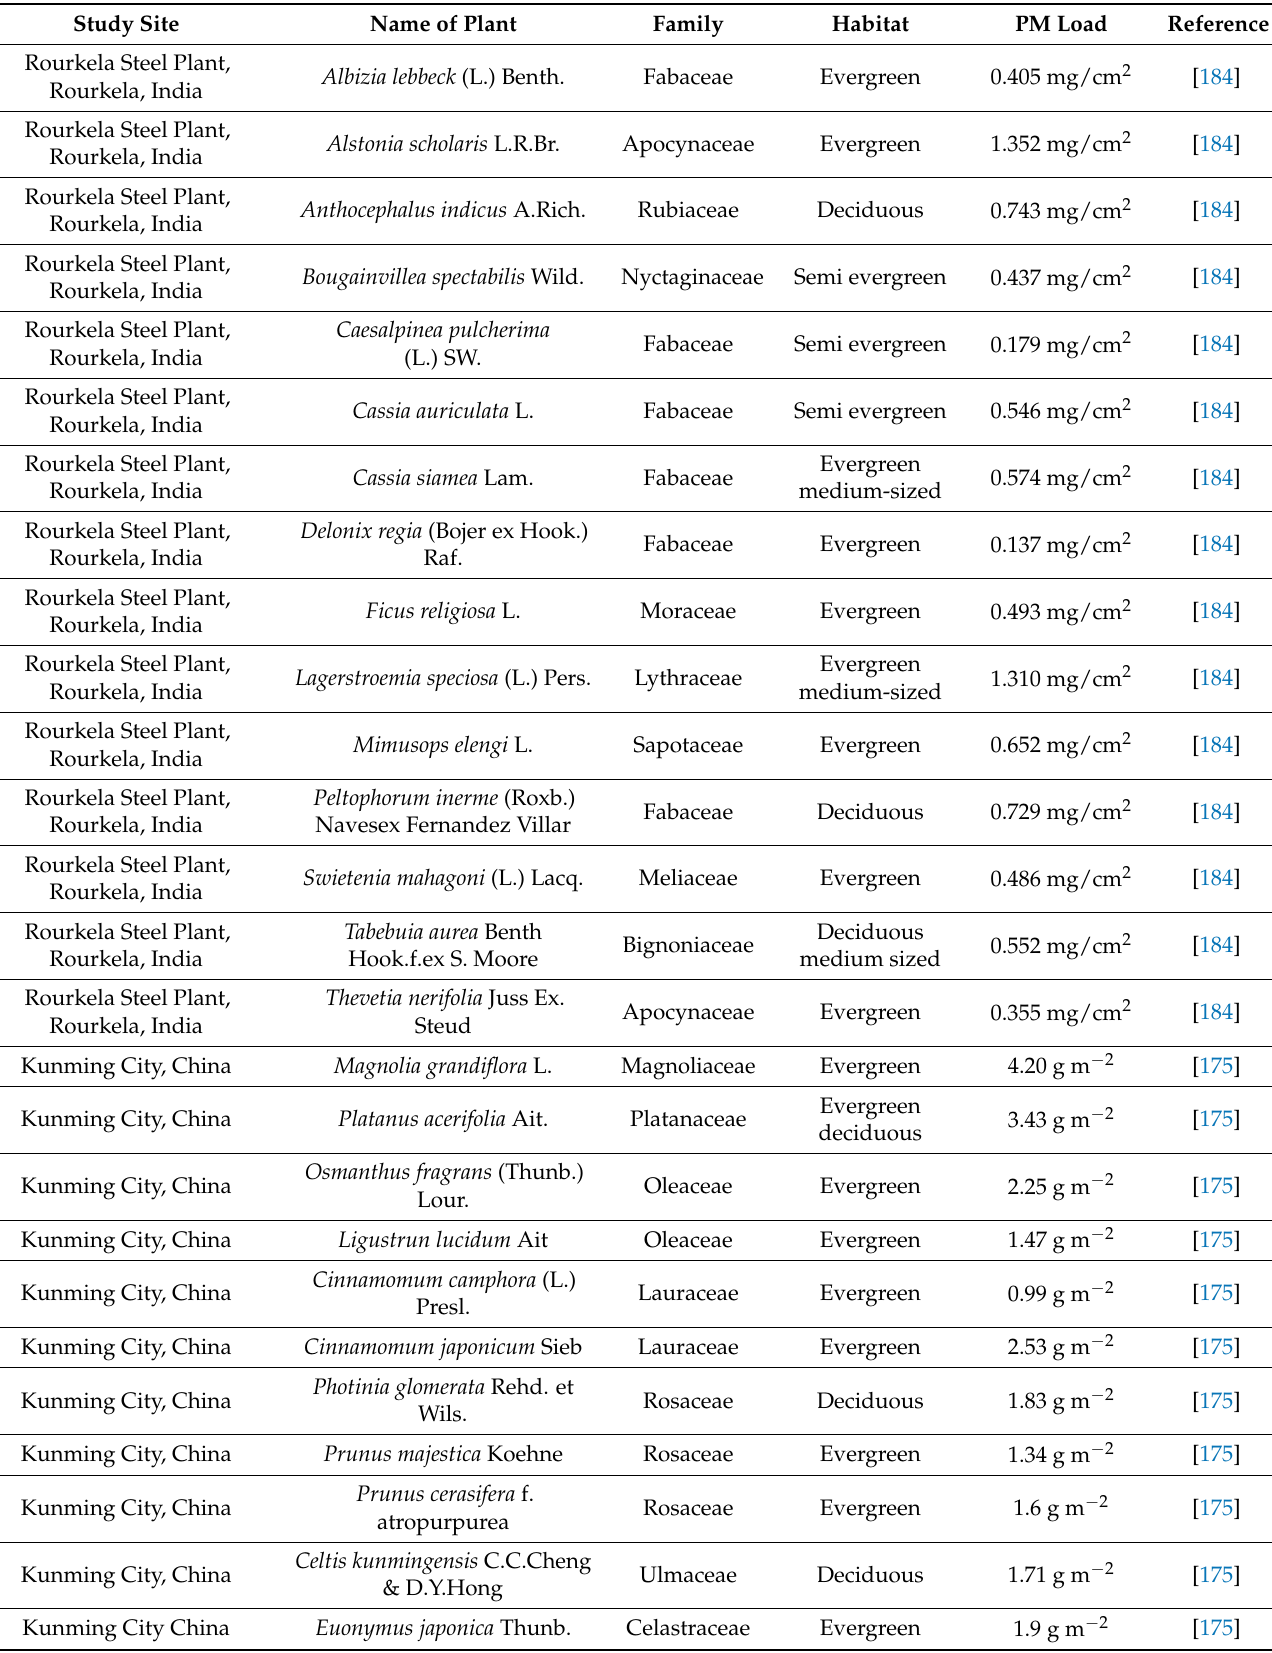
Table 2. List of PM load capacity on different plant species from previous